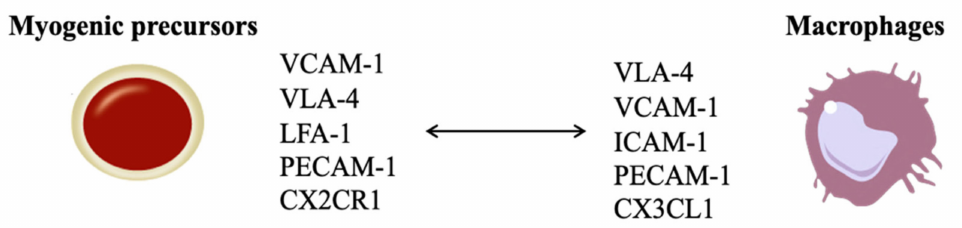
Figure 4. Schematic representation of myogenic precursors and macrophages crosstalk. A functional crosstalk is established between myogenic precursors and macrophages to promote cells survival and proliferation during skeletal muscle healing. Macrophages expressed the vascular cell adhesion molecule 1 (VCAM-1), intercellular cell adhesion molecule binding 1 (ICAM-1), platelet-endothelial cell adhesion molecule homophilic (PECAM-1) and C-X3-C motif chemokine ligand 1 (CX3CL1); all these signals interact with their counter-ligands on myogenic precursors: very late antigen 4 (VLA-4), leukocyte function-associated molecule 1 (LFA-1), platelet-endothelial cell adhesion molecule homophilic (PECAM-1), and C-X2-C motif receptor 1 (CX2CR1), respectively. Moreover, myogenic precursors express VCMA-1 that interact with VLA-4 of immune cells. Table 3. Macrophages and myogenic cells precursors: a functional crosstalk. In vitro and in vivo studies. Cell Culture